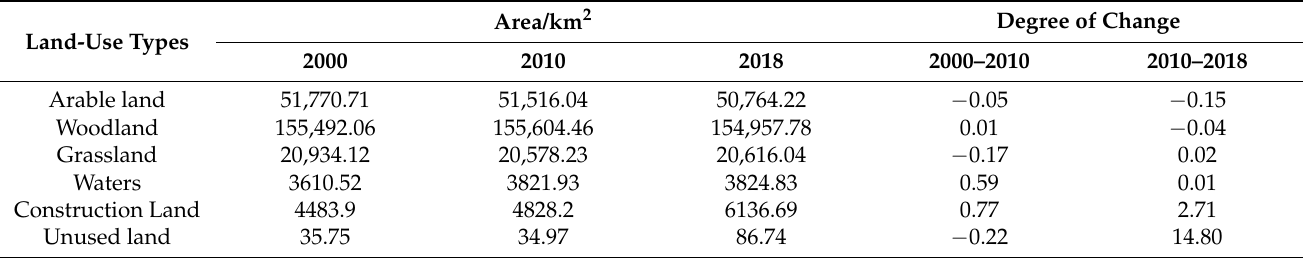
Table 2. Area and changes in land-use types in Guangxi from 2000 to